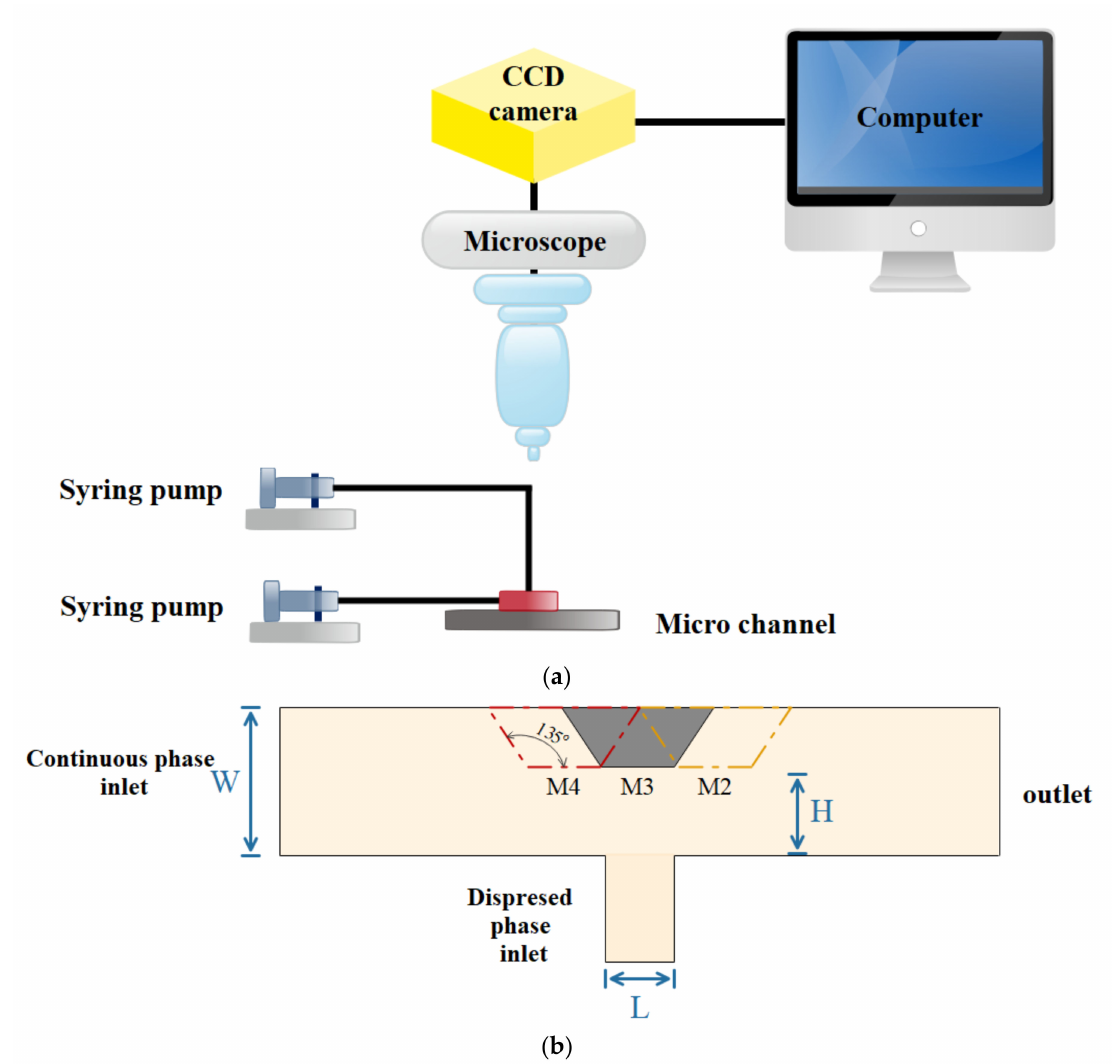
Figure 21. ( a ) Experimental apparatus schematic; ( b ) ordinary and modified T-shaped microchannel schematics